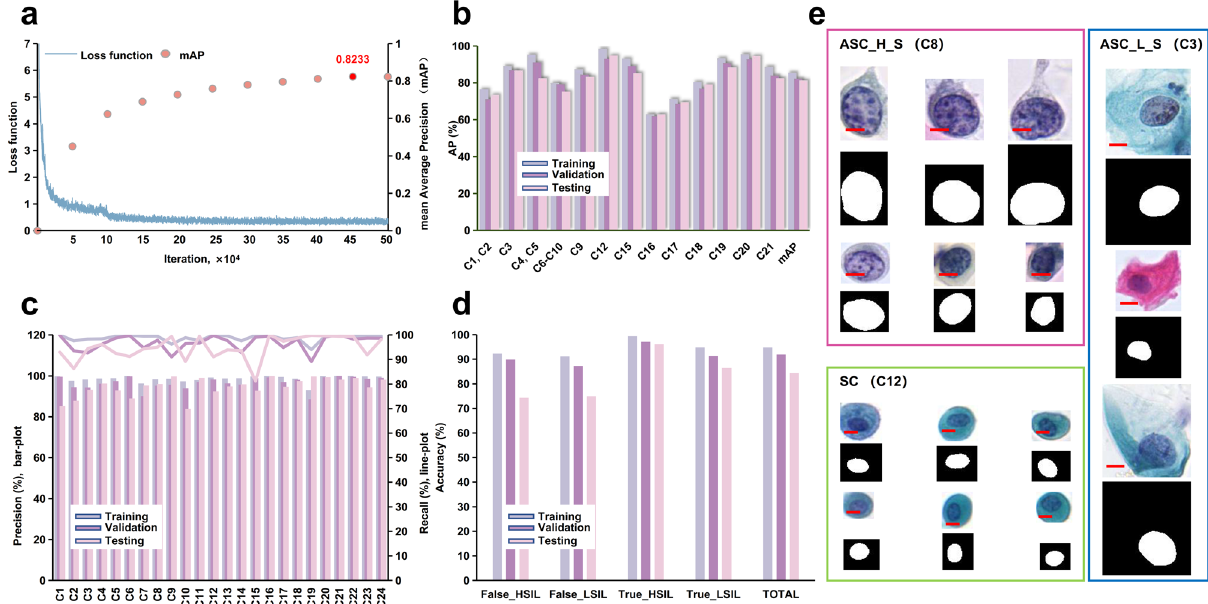
Fig. 3 Training of the deep learning models and their performance. a The loss function and mean Average Precision (mAP) of YOLOv3 model during the training. b The AP of 13 TBS classi fi cations in YOLOv3 model. The corresponding classi fi cation indexes are shown in Fig. 2a and Table 1. c The precision and recall of 24 classi fi cations in the Xception model. (Bar-plot: precision; Line-plot: recall). The corresponding names of each classi fi cation as show in Fig. 2a and Table 1. d The accuracy of False_HSIL, True_HSIL, False_LSIL, and True_LSIL in Patch model. e The representative images of ASC_L_S (blue box), ASC_H_S (red box), and SC (green box) in the nucleus segmentation model (true color image: original images, binary image: corresponding masks; Scale Bars: 10 μ m). NATURE COMMUNICATIONS| (2021) 12:3541 |https://doi.org/10.1038/s41467-021-23913-3|www.nature.com/naturecommunications